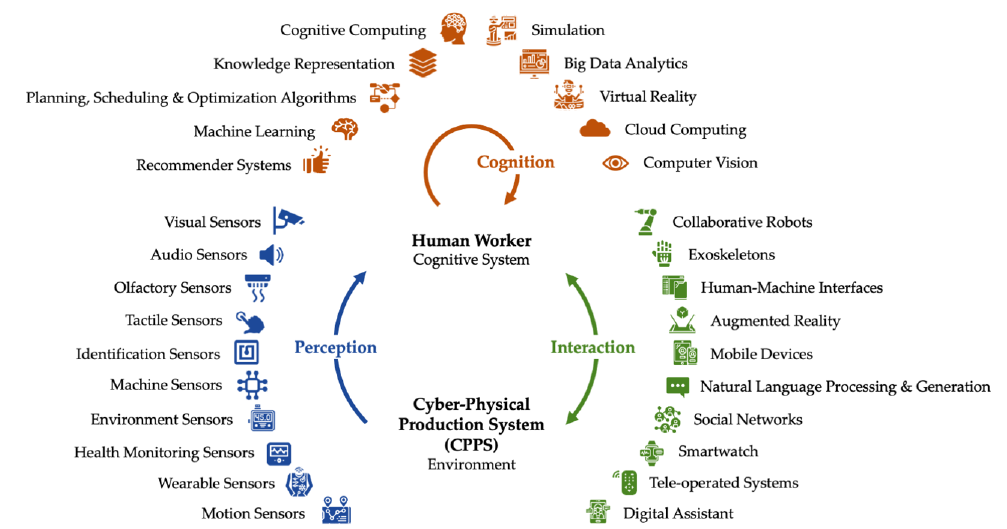
Figure 2. Towards human–machine symbiosis in the Industry 5.0: technology-augmented human capabilities as part of a cognitive process. 148